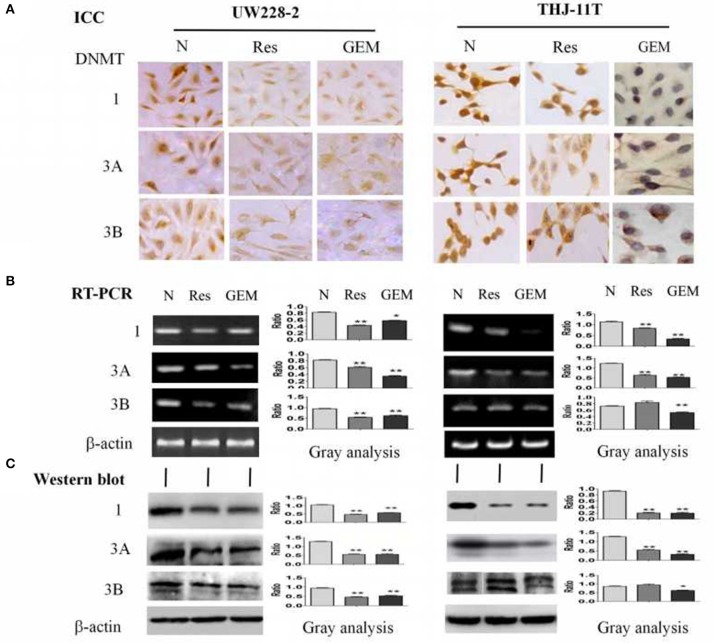
Demonstration of suppressed DNMT1, DNMT3A, and DNMT3B expression in 100 μM resveratrol (Res) or 10 μM gemcitabine (GEM) treated THJ-11T and UW228-2 cells for 48 h. (A) Immunocytochemical staining (×40); (B) RT-PCR; (C) Western blotting. β-actin was used as qualitative and quantitative control. N, cultured in 0.2% dimethylsulfoxide (DMSO)-containing medium; Res, 100 μM resveratrol; GEM, 10 μM gemcitabine. Ratio, the ratio between the levels of the target molecules and that of β-actin; NS, no statistical significance (p > 0.05); *with statistical significance (p < 0.05); **p < 0.01; ***p < 0.001; the error bars, the mean ± standard deviation.